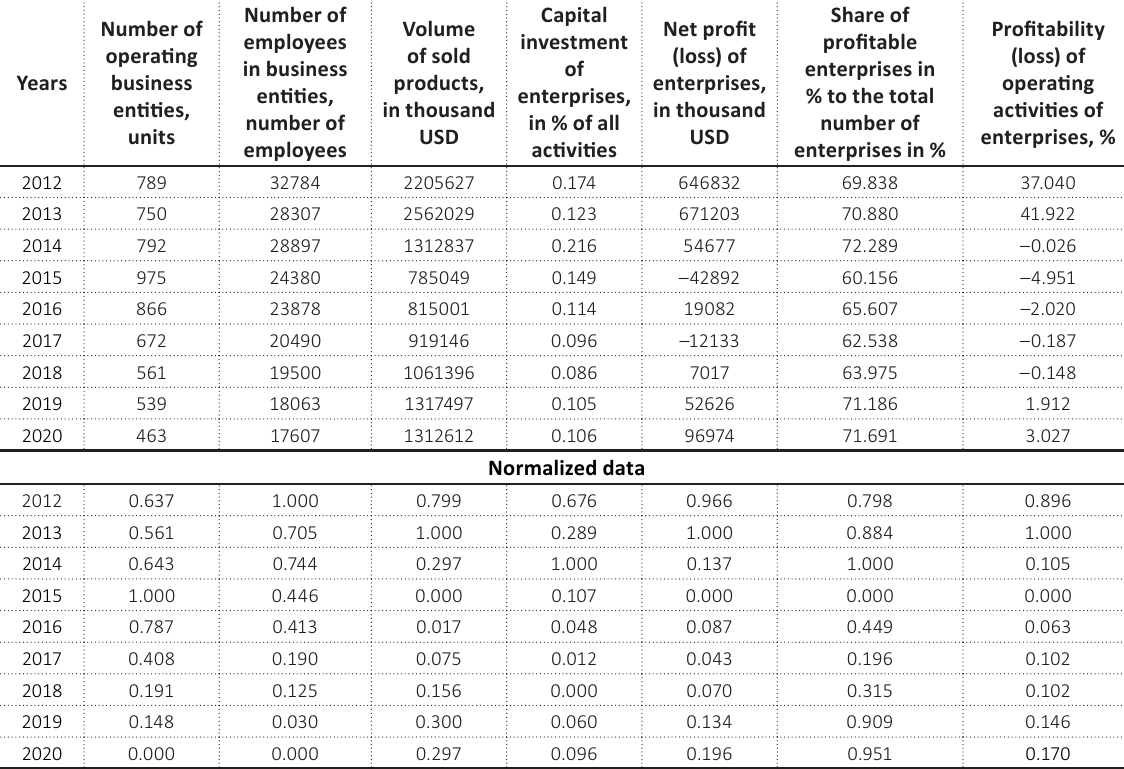
Table 2. Main indicators of the competitiveness of the insurance sector in